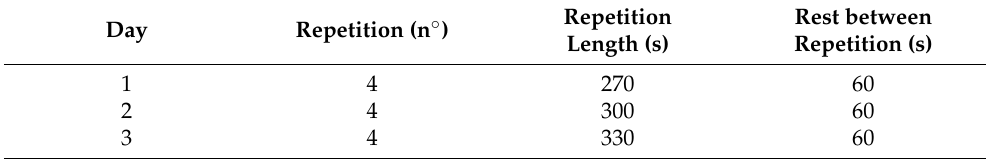
Table 4. Dosage of the virtual reality exercises for the following four weeks of home